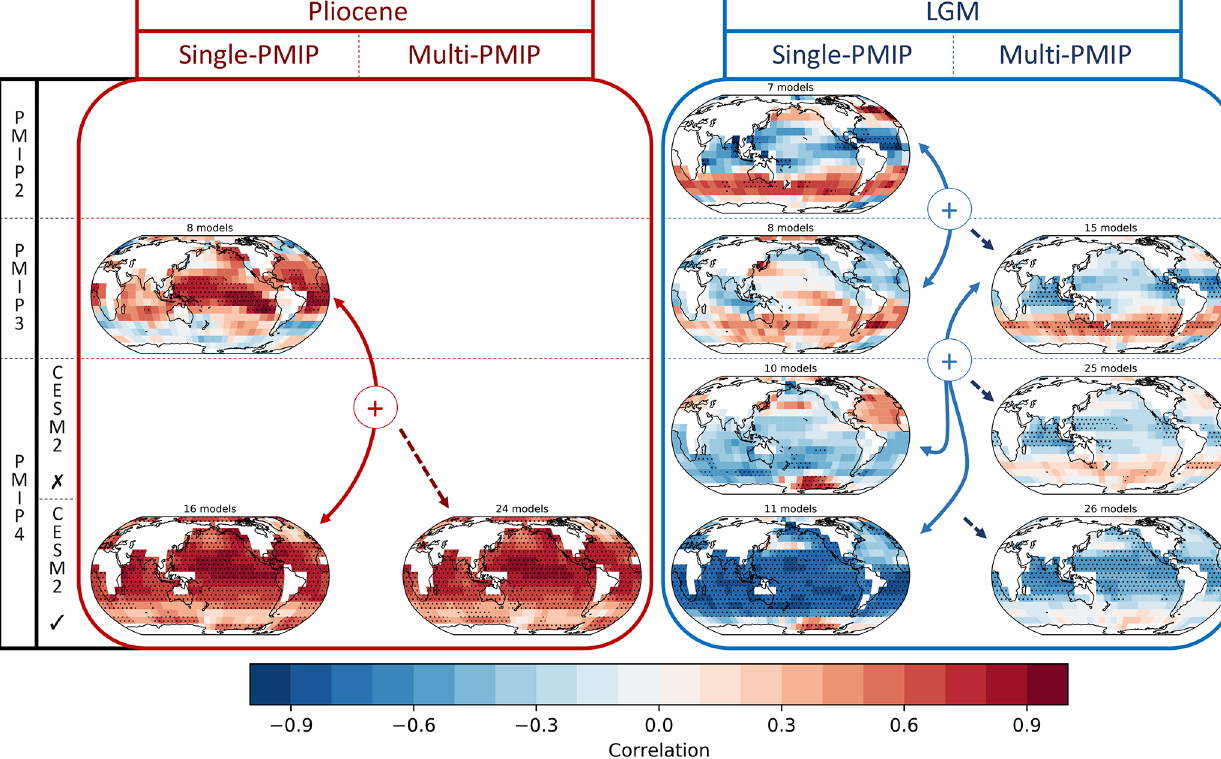
Figure 2. Summary of the correlation between SST anomaly and ECS through different PMIP generations. Models have been regridded on 10 ◦ grids to minimize dependency between neighboring cells. For both Pliocene and LGM, the left-hand side figures correspond to the correlation existing in each individual generation of PMIP, while the right-hand side figures are the combination of several generations, following the “ + ” sign. In PMIP4, the upper row shows ensembles with CESM2.1 included, while lower row shows ensembles excluding CESM2.1. Discussions regarding the presence of CESM2.1 are made in Sect. 6. Red dotted areas are of positive significance; blue dotted areas are of negative significance under a one-sided t test (95%